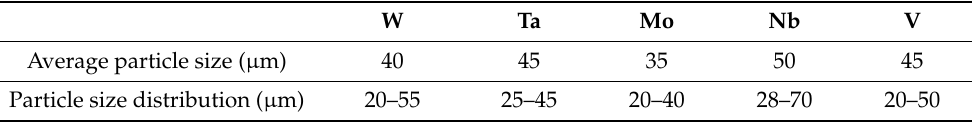
Figure 1. General views of the elemental powders used to produce the HEA WTaMoNbV by LPBF process. Table 4. Pure elemental alloying powders—particle size and distribution.